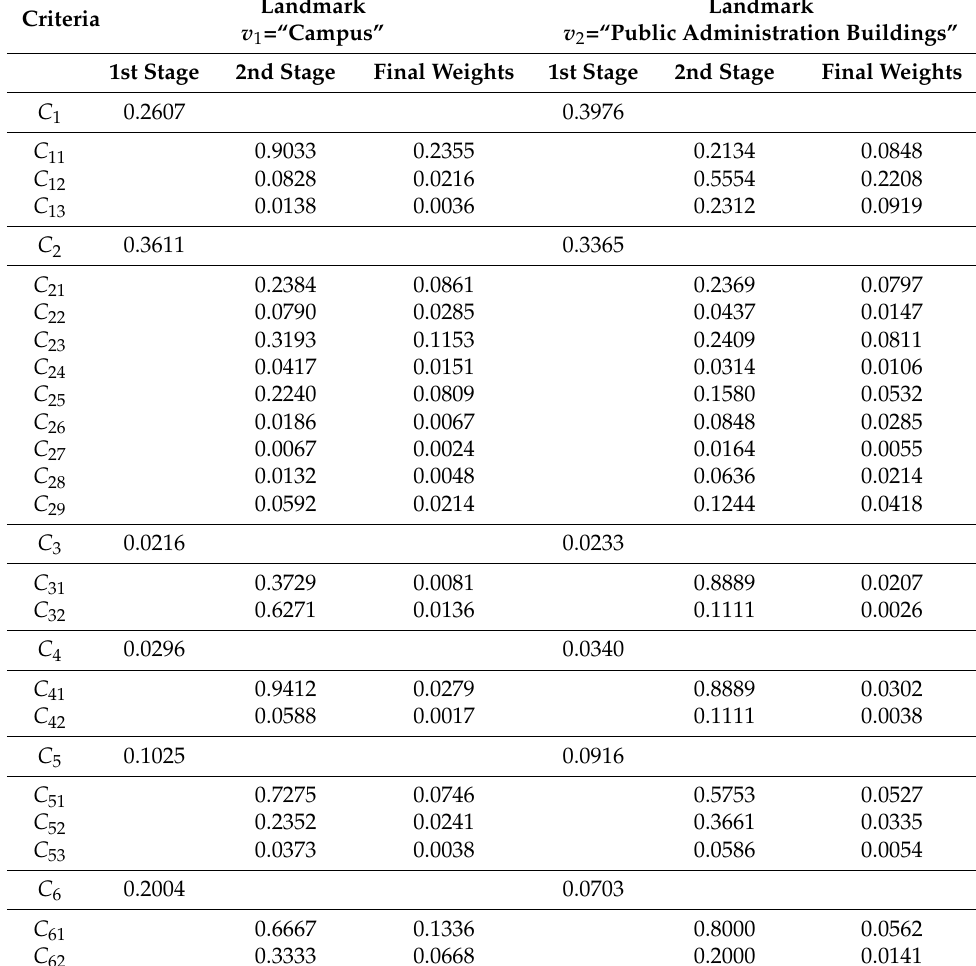
Table A2. AHP evaluation of criteria using the power